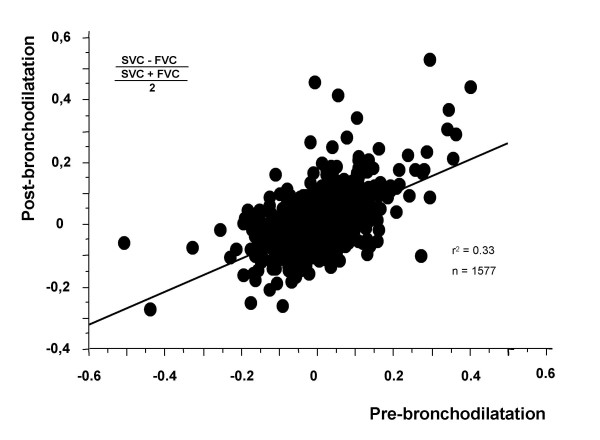
Relationship between pre- and post-bronchodilator slow (SVC) and forced (FVC) vital capacity corrected for VC-level in 1577 smokers with a pre-bronchodilator FEV1/VC -ratio below 0.75.